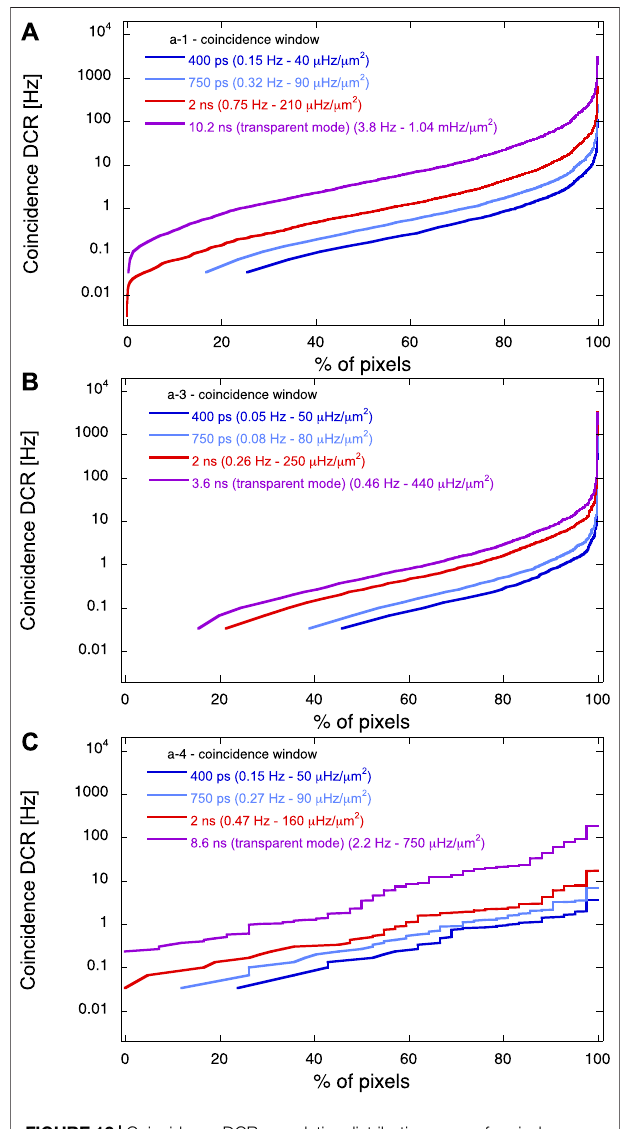
FIGURE 12 | Coincidence DCR cumulative distribution curves for pixels in adual-layer sample from (A) an a -1, (B) an a -3and (C) an a -4array.In each fi gure, the curves were measured at different values of the coincidence window